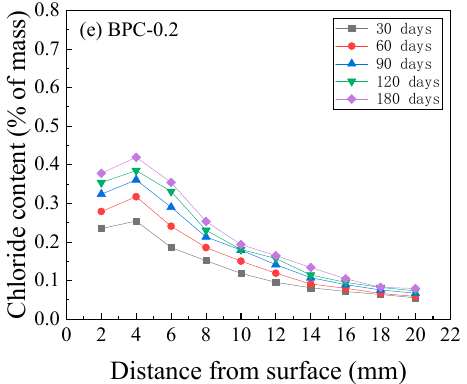
Figure 3. Chloride content distribution of the HBPRC: ( a ) NC; ( b ) BC-0.1; ( c ) PC-0.1; ( d ) BPC-0.1; ( e ) BPC-0.2.